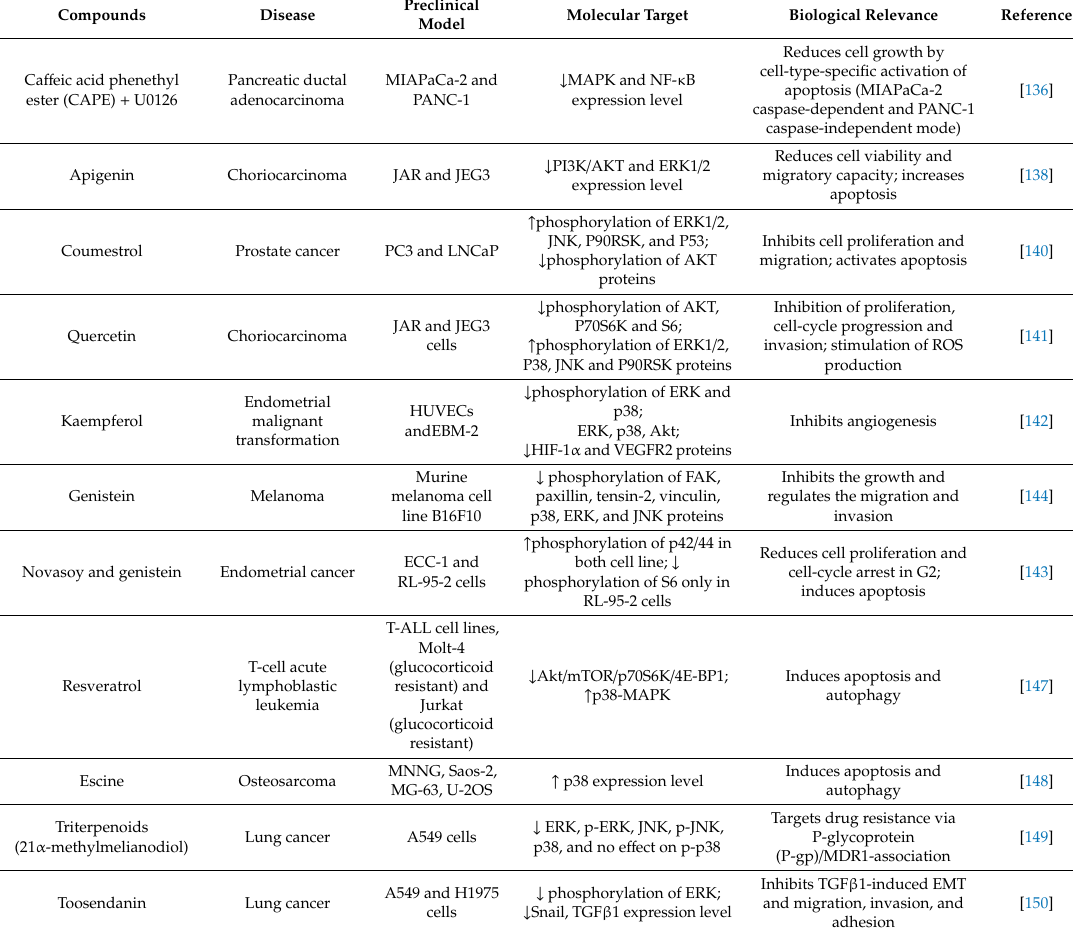
Table 4. Some relevant examples involving the capacity of natural bioactive agents to regulate MAPK in parallel with another related pathway involved in cancer progression and